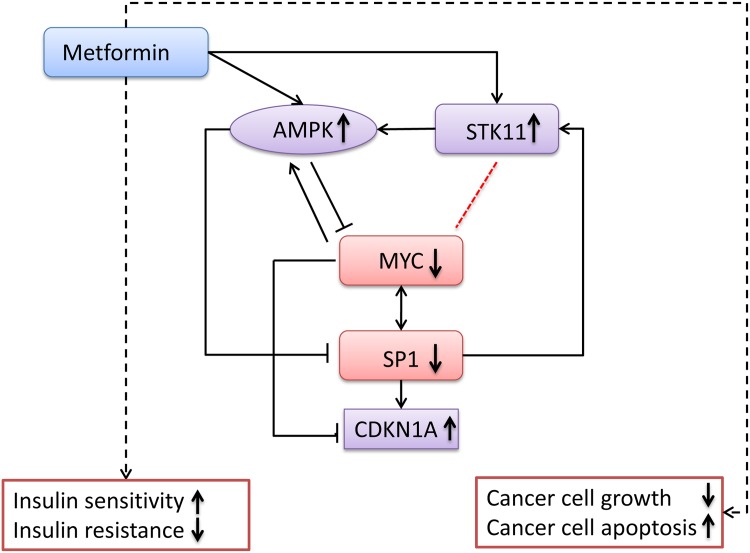
A novel metformin action pathway.Solid lines indicate the proposed mechanisms as supported by experimental evidence from literature. The two black dashed lines indicate the drug effects. The red dashed line indicates the relationship is existed but the direction is unknown. The arrows beside the gene names or biological processes indicate the metformin effects. Up-arrows indicate the corresponding genes or processes are up-regulated while the down-arrows indicate the corresponding genes or process are down-regulated.